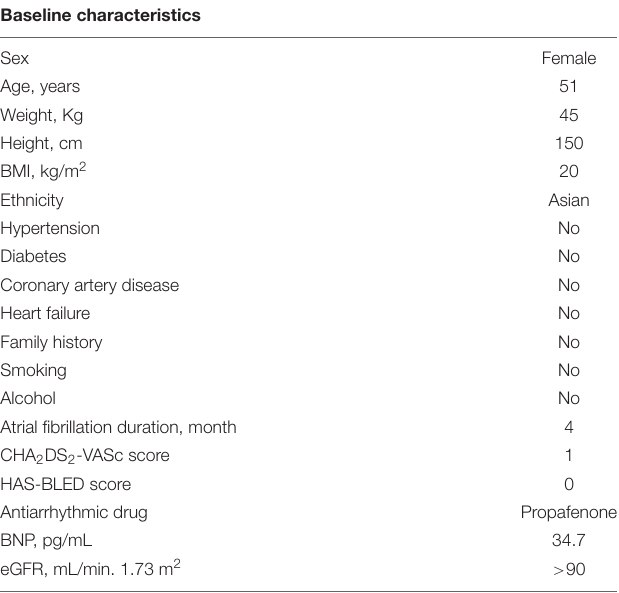
TABLE 1 | Baseline characteristics. Baseline